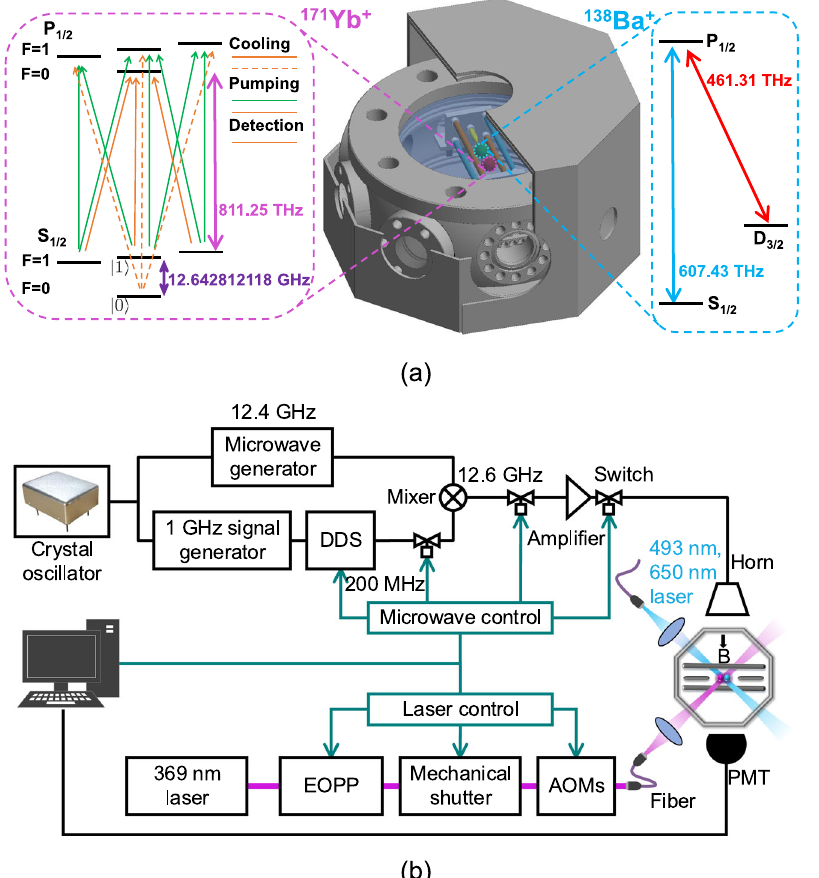
Fig. 1 Experimental setup. a Energy levels of 171 Yb + and 138 Ba + ion and cutaway view of the μ -metal shielding enclosing octagon chamber. The shielding has ten holes, where two holes for connection of the vacuum pump and helical resonator and the other eight holes with diameter from 20 to 40 mm for the access of laser beams, microwave, and imaging system. b The schematic diagram for the control of microwave and laser beams. We use a crystal oscillator (SIMAKE SMK3627OCHFM OCXO) to reference the microwave generator and Direct Digital Synthesize (DDS) through a 1 GHz signal generator. The microwave of 12.6 GHz is generated by mixing 200 MHz signal from DDS and 12.4 GHz from the microwave generator, which is ampli fi ed and applied to ions through a horn. All three microwave switches are used to reduce microwave leakage. For 369 nm laser beams, we use acousto-optic modulators (AOMs) to generate basic operating lasers. We use Electro-Optic pulse picker (EOPP), mechanical shutter and single-mode fi ber to reduce laser leakage. The magnetic- fi eld direction is in the radial direction. We detect the qubit state with a photomultiplier tube